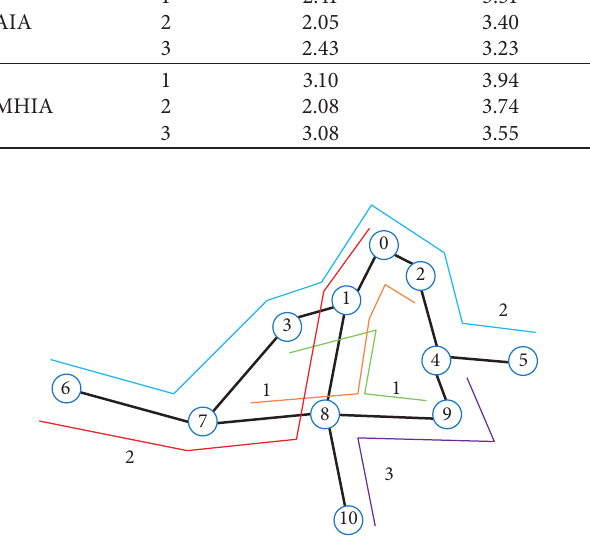
Figure 5: The best line plan of PDS 1 obtained from MHIA.